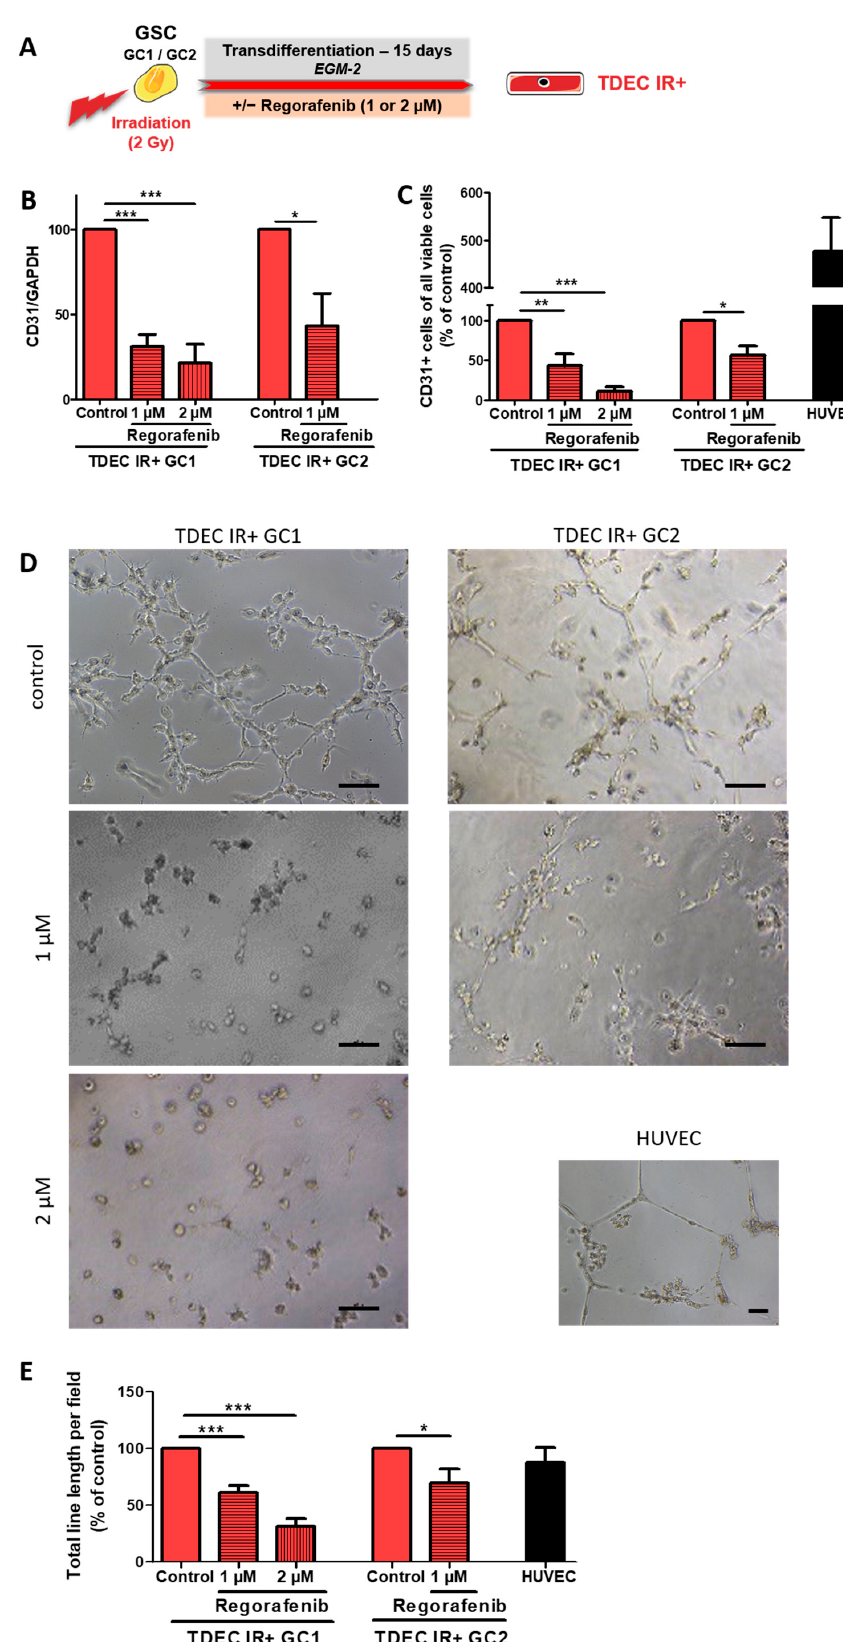
Figure 4. Regorafenib inhibits irradiation-induced transdifferentiation in vitro. ( A ) GSC isolated from 2 patients (GC1 and GC2) were irradiated (2Gy) and then cultured in EGM-2 for 15 days